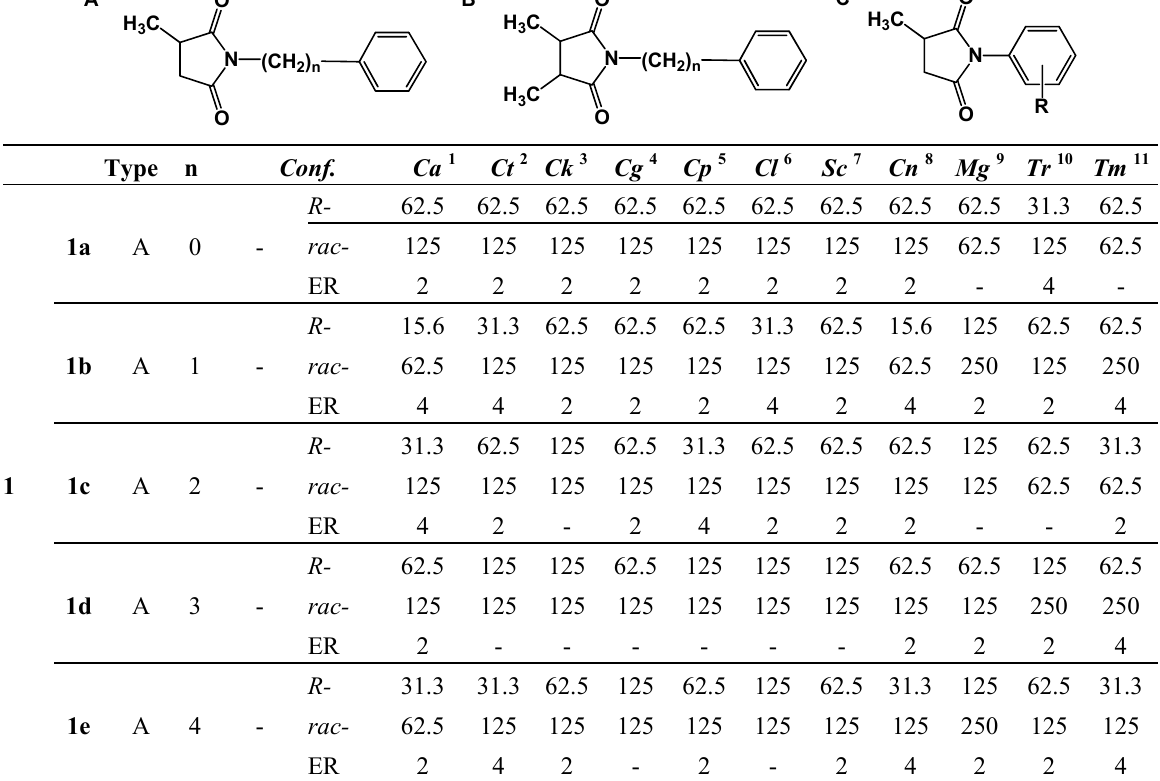
Table 2. Antifungal activity (MICs in μ g·mL − 1 ) of 3-methyl- N- phenyl- or N-